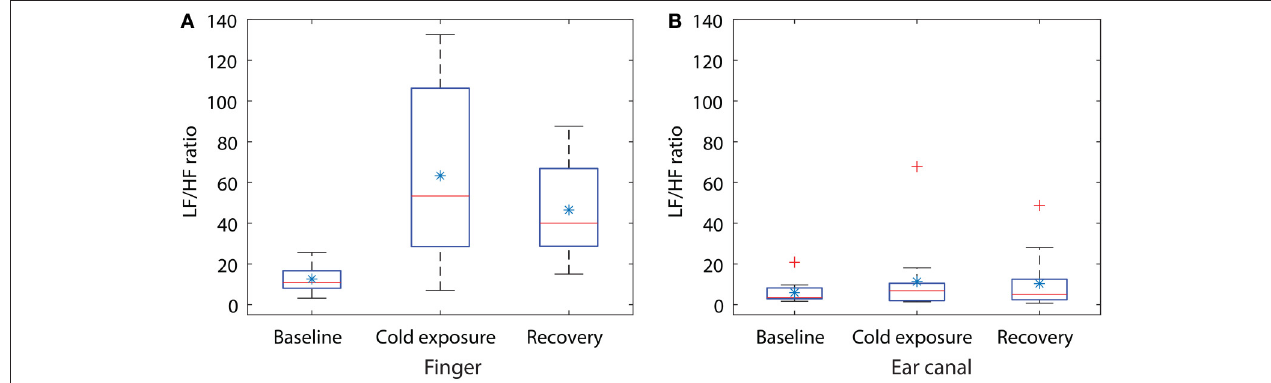
FIGURE 4 | Box plot showing the changes in LF/HF ratio during the cold exposure in (A) finger and (B) the ear canal. Each box represents the interquartile range of the mean LF/HF power ratio measured from 12 volunteers. The red line in each box shows the median value of the data, the ∗ shows the mean and + shows the outliers.